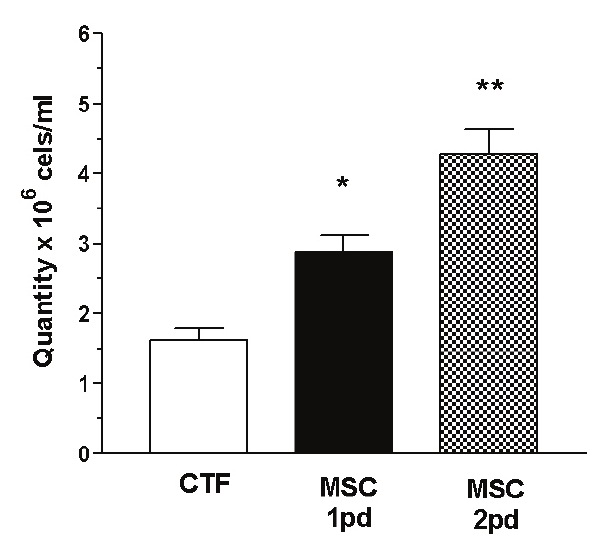
FIGURE 4 - Histogram representing the total cells extracted from adipose panicle rabbit (CTF) and cultivated mesenchymal stem cells after first passage (MSC - 1pd) and second passage (MSC - 2pd). The columns and bars respectively indicate mean ± standard error of mean of cells from 10 rabbits. Statistically different from the CTF, * 0.001 and ** p ≤ p ≤ 0.0001 (Student t-test).